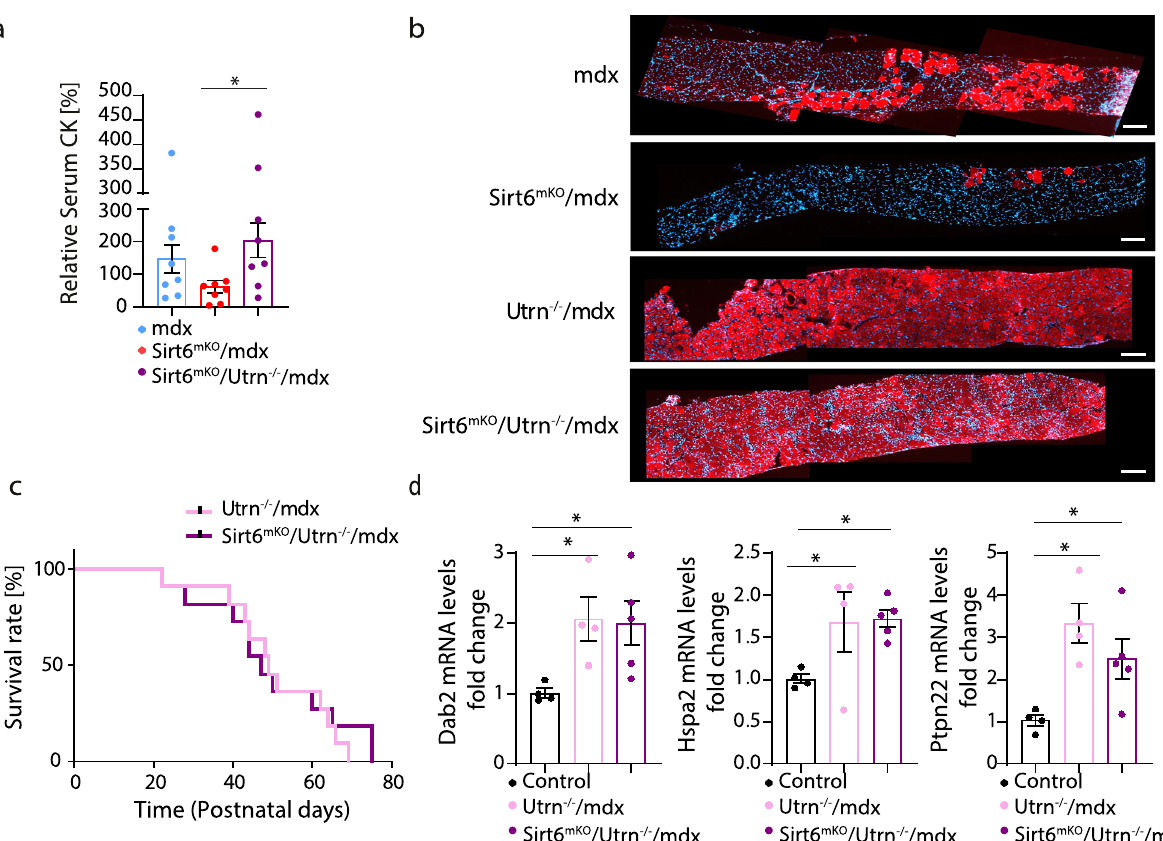
Fig. 7 Deletion of Utrn abrogates bene fi cial effects of Sirt6 inactivation in Sirt6 mKO /mdx mice. a Serum creatine kinase (CK) enzyme activity relative to mdx ( n = 8), Sirt6 mKO /mdx ( n = 8), and Sirt6 mKO /Utrn − / − /mdx ( n = 8) mice (One-way ANOVA with Benjamini multiple comparisons test: * p = 0.0229). b Evans blue staining of diaphragm muscles from mdx ( n = 3), Sirt6 mKO /mdx ( n = 4), Utrn − / − /mdx ( n = 2) and Sirt6 mKO /Utrn − / − /mdx ( n = 4) mice. Cross-sectional images showing myo fi ber leakage in red color are shown. Scale bar: 100 μ m. c Cumulative survival curve of Utrn − / − /mdx ( n = 11) and Sirt6 mKO /utrn − / − /mdx mice ( n = 11). Kaplan – Meier curve and Log-rank test. d RT-qPCR analysis of expression of genes involved in cellular stress responses in control ( n = 4), Utrn − / − /mdx ( n = 4), and Sirt6 mKO /Utrn − / − /mdx ( n = 5) muscles. m36b4 was used as a reference gene (One-way ANOVA with Benjamini multiple comparisons test: Dab2: * p = 0.0259, * p = 0.0265; Hspa2 : * p = 0.0437, * p = 0.0280; Ptpn22 : * p = 0.0034, * p = 0.0290). Five to eight weeks old male and female mice were used. Data are presented as mean ± SEM. Source data are provided in the Source Data fi